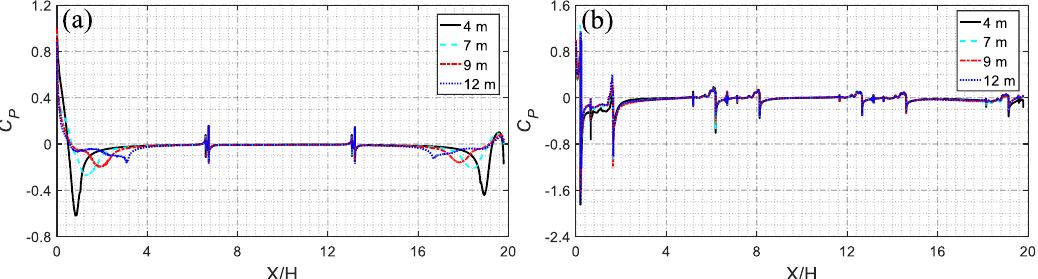
Figure 14. Train surface distribution of time-averaged pressure coefficient ( C P ) at y = 0 m: ( a ) top, and ( b ) lower surface.